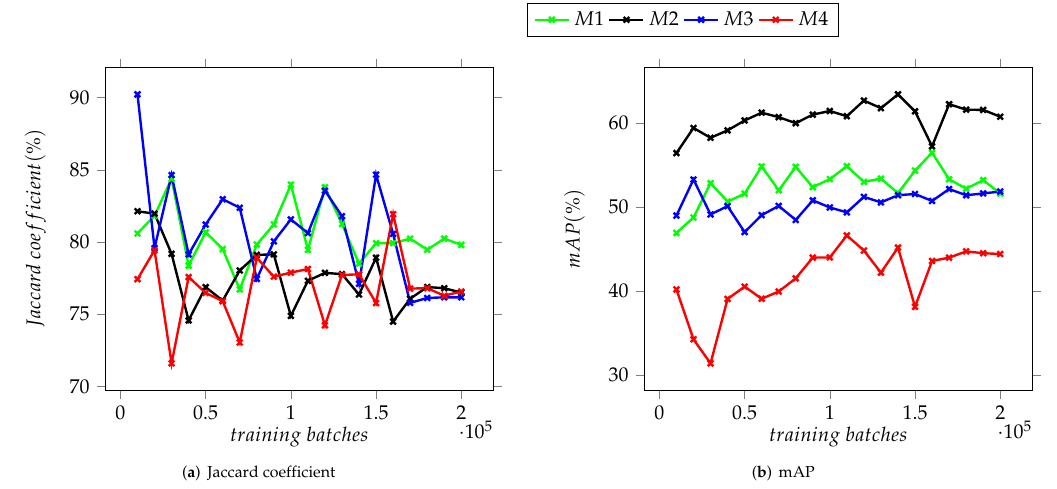
Figure 8. Average Jaccard coefficient and mAP for the trained detection models on validation Dataset I.